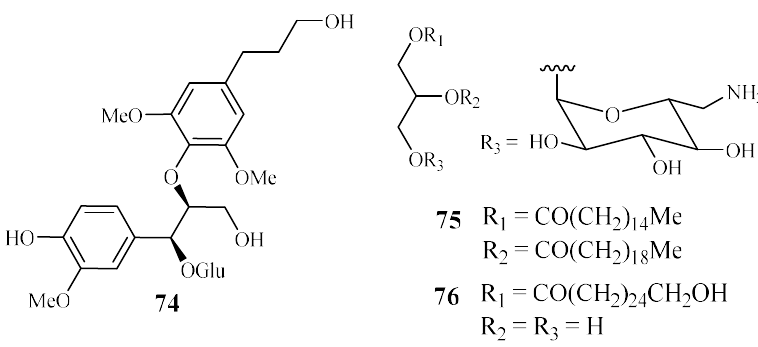
Figure 12. Compounds from a Connaraceae plant.